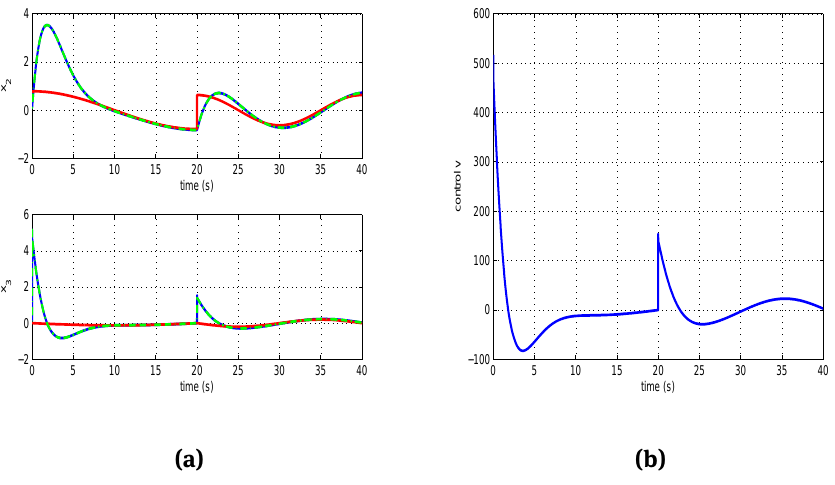
Fig. 7: Setpoint 5: (a) Convergence of the state variables of the SRM x 2 = ω , x 3 = ˙ ω (blue line: real value, green line: estimate value) by the H-infinity filter) to the associated reference values (red line). (b) Control input v applied to the control system of the